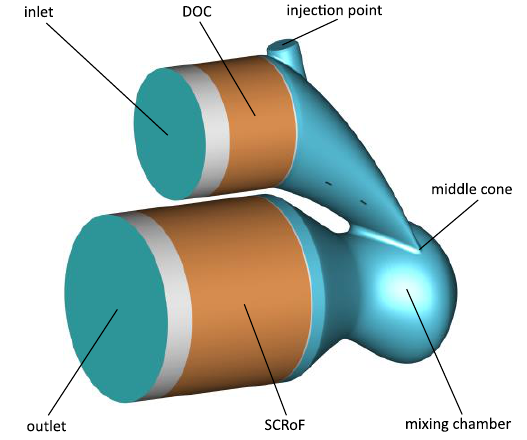
Fig. 1. Geometrical model of the considered close-coupled SCR system